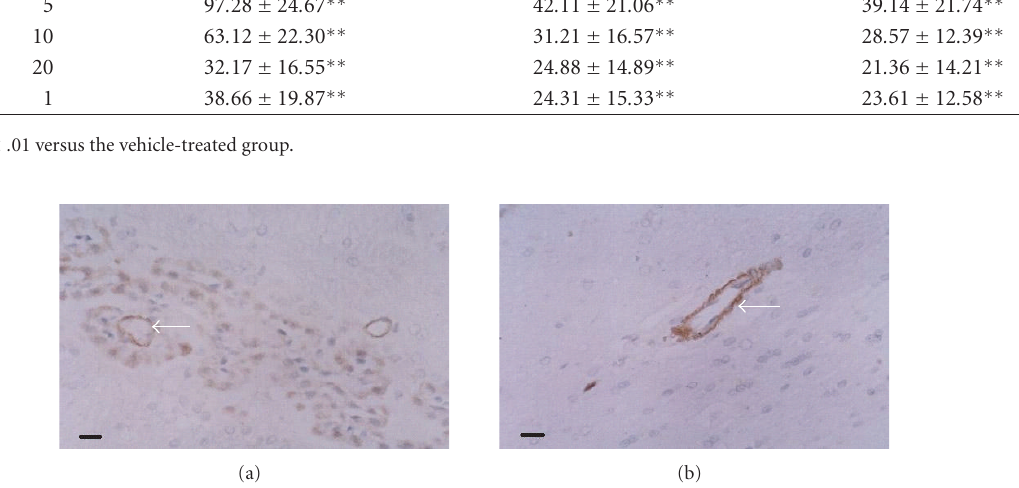
Figure 2: Immunohistochemical staining of ICAM-1 in brain tissues of (a) vehicle-treated rats and (b) theaflavin-treated rats (20mg/kg), SP × 400. ICAM-1 protein is mainly expressed on the microvascular endothelial cells. ICAM-1 expression decreases dramatically in theaflavin- treated groups. Scale bar = 10 μ m.